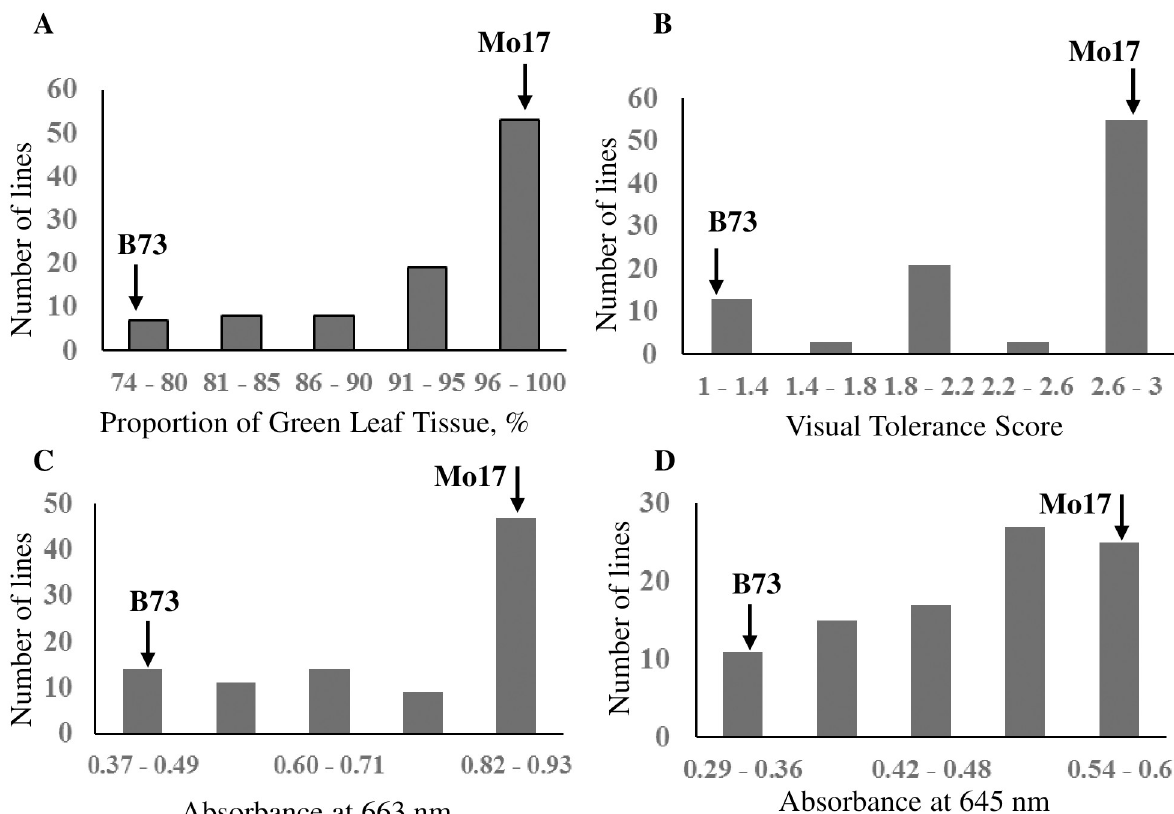
Fig 2. Frequency distributions of leaf color—Related traits following low temperature exposure in the IBM Syn4 population of RIL lines. A. Proportion of green leaf tissue following low temperature exposure; B. Visual cold tolerance score following low temperature exposure; C. Absorbance of methanol leaf extracts measured at 663 nm; D. Absorbance of methanol leaf extracts measured at 645 nm. Arrows show the relative position of B73 and Mo17 parents.